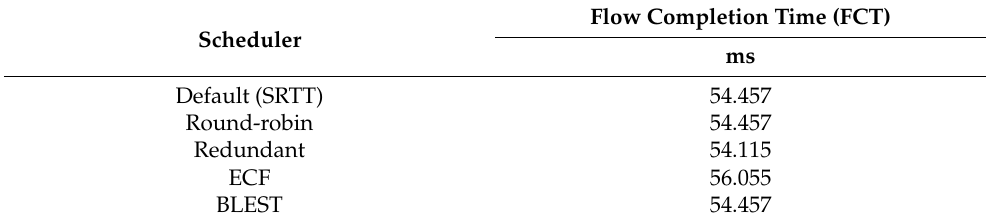
Table 5. Performance of the tested MPTCP schedulers in terms of FCT for wVegas as a